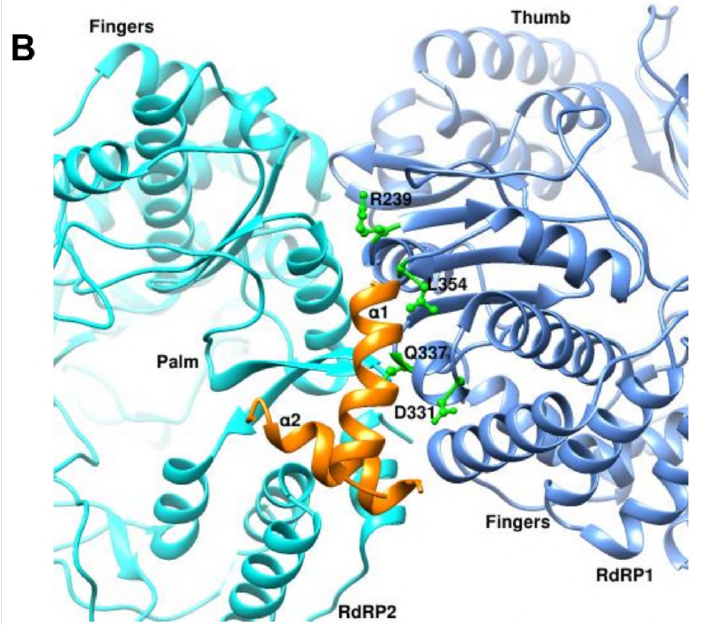
Figure 2. The RdRP–VPg complexes of caliciviruses . ( A ) Multimerization of MNV RdRP–VPg complex. Six monomeric units of RdRP of MNV (PDB 5Y3D), shown in shades of blue, associate with each other and the VPg moiety (shown as orange ribbons) to form efficient ball-like replication machinery. ( B ) Zoomed-in view of a single MNV RdRP–VPg interaction unit. The close-up of the two molecules of MNV RdRP is shown in shades of blue with the interacting helices of VPg ( α 1 and α 2) shown in orange. The residues of the RdRP participating in the interaction with the VPg are also shown in ball-and-stick representation and colored